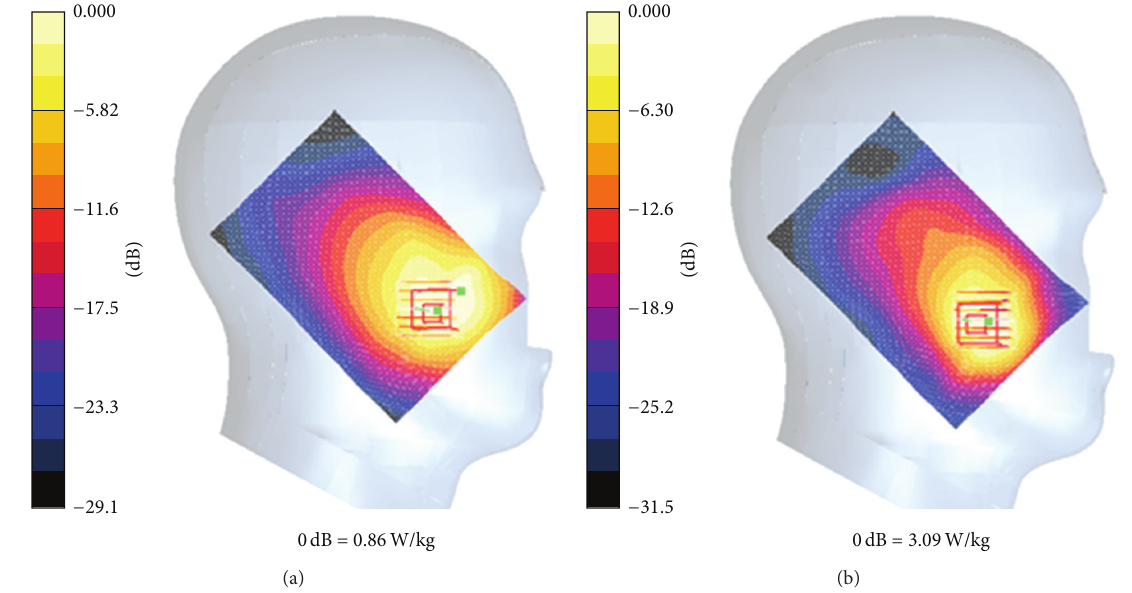
Figure 13: Measured SAR distributions in the head phantom (a) at 840 MHz and (b) at 1850 MHz (input power: 0.1W). Table 1: Relative permittivity and conductivity in the simulation.